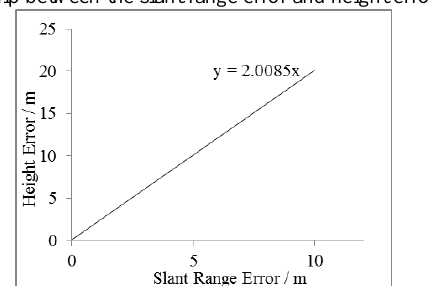
Figure 6. Relationships between the slant range error and height measurement